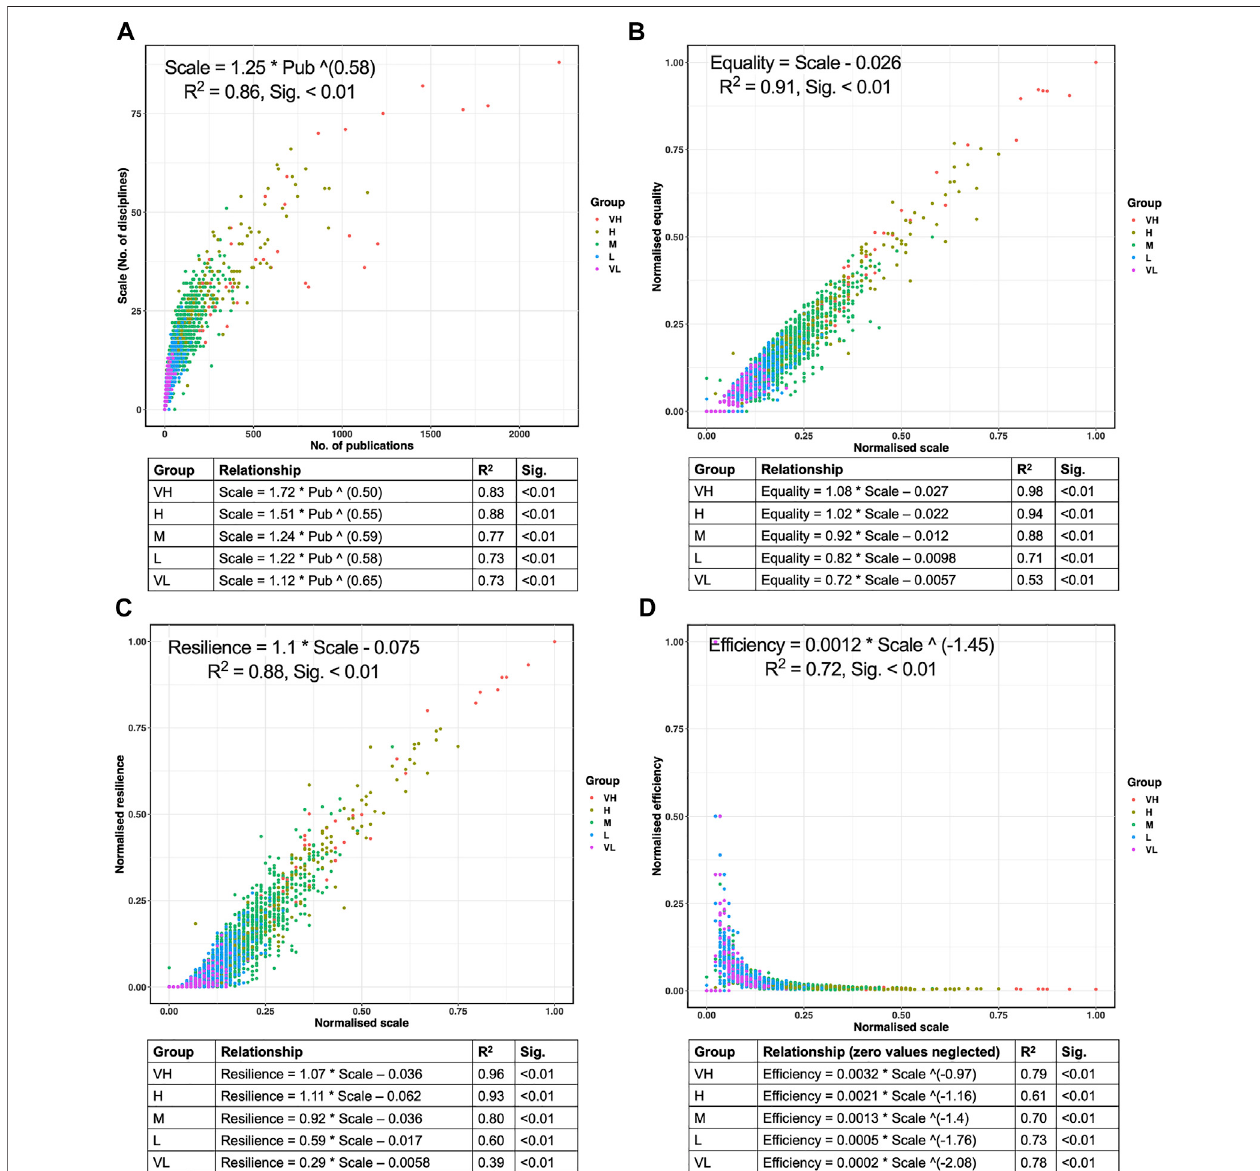
FIGURE 3 | (A) Relationships between the publication and scale, and between the scalar and structural metrics of (B) equality and scale, (C) resilience and scale, and (D) ef fi ciency and scale among fi ve publication groups.